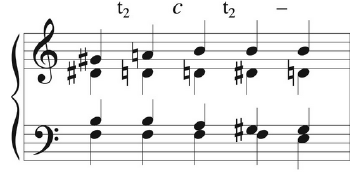
Figure 12. Figure 27 from